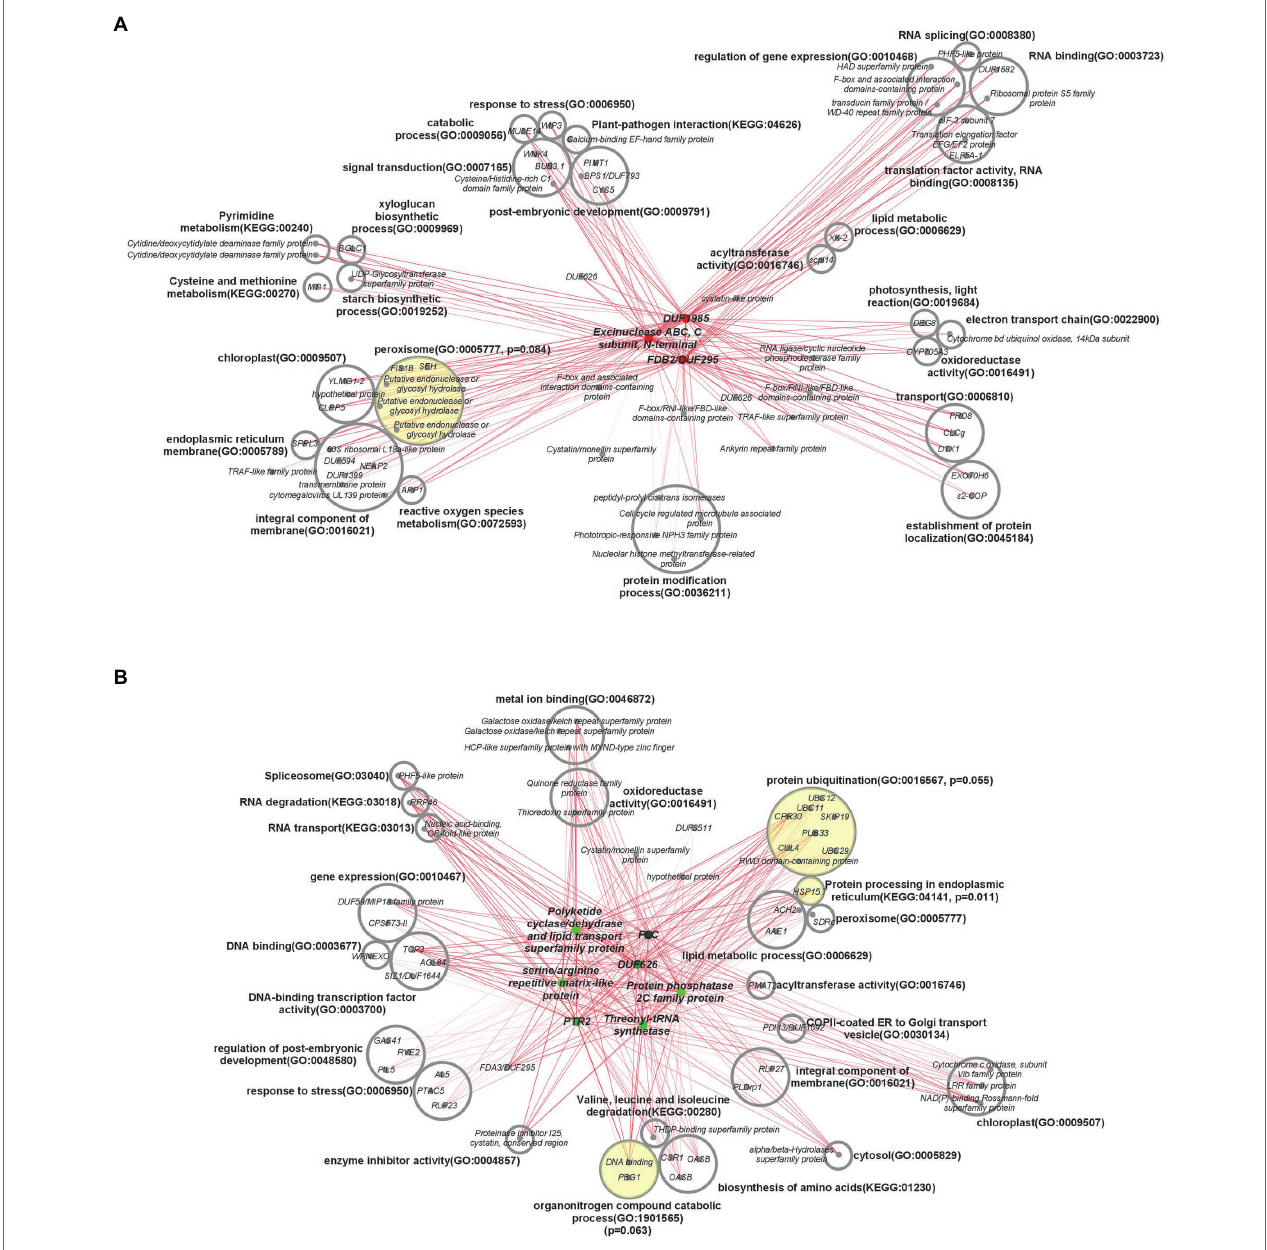
FIGURE 7 | Central coexpression network of DEGs containing top 10 major hub genes and their respective first neighbors. (A) Three main hub genes that were upregulated in high oil accession, (B) seven main hub genes that were downregulated in high oil accession. Hub genes are in the center of each network, in color, and first neighbor genes are categorized by gene ontology terms. Circles with yellow shading indicate over-represented gene ontology terms, with p -values based on the false discovery rate, and their associated genes. DUF = gene with a domain of unknown function. Darkness of lines indicates correlation, with darker indicating higher correlation. ORA was carried out using a threshold of